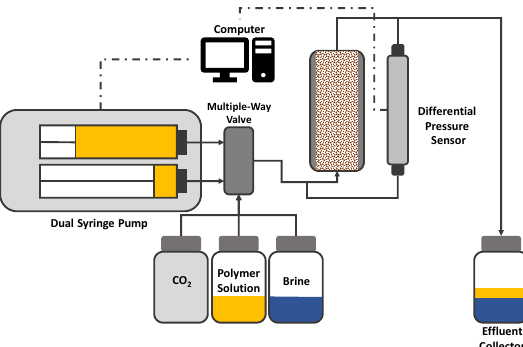
Figure 15. Schematic sketch of a sand pack setup used for experiments at room temperature. For experiments at elevated temperatures, the cell containing the sand and the inlet/outlet pipes needs are placed in an oven.